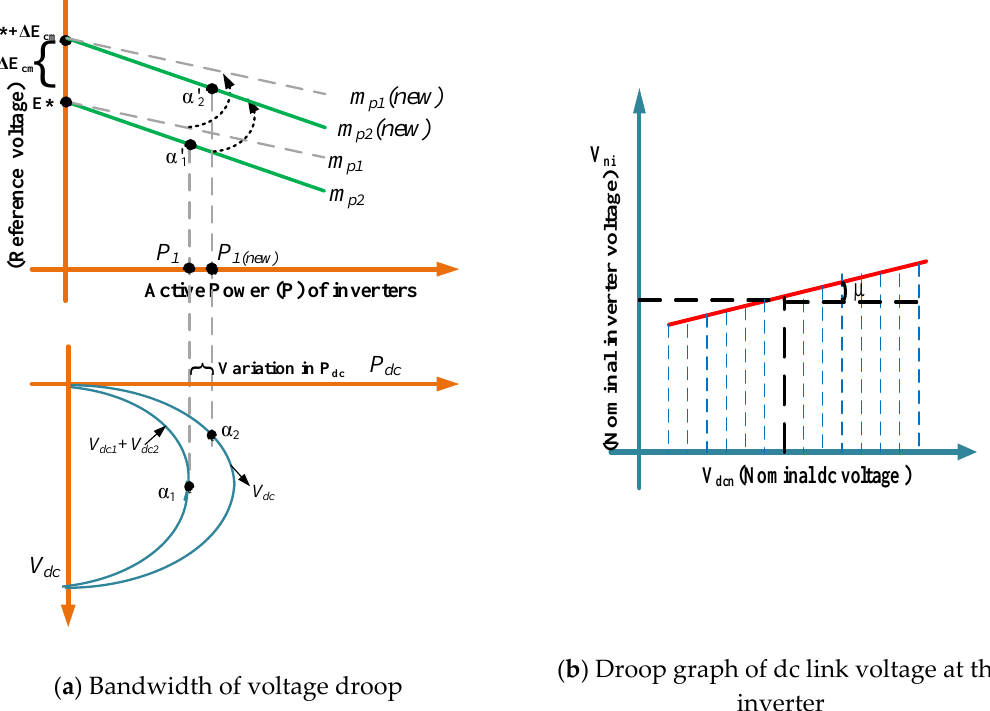
Figure 5. Characteristic droop analysis of proposed method.